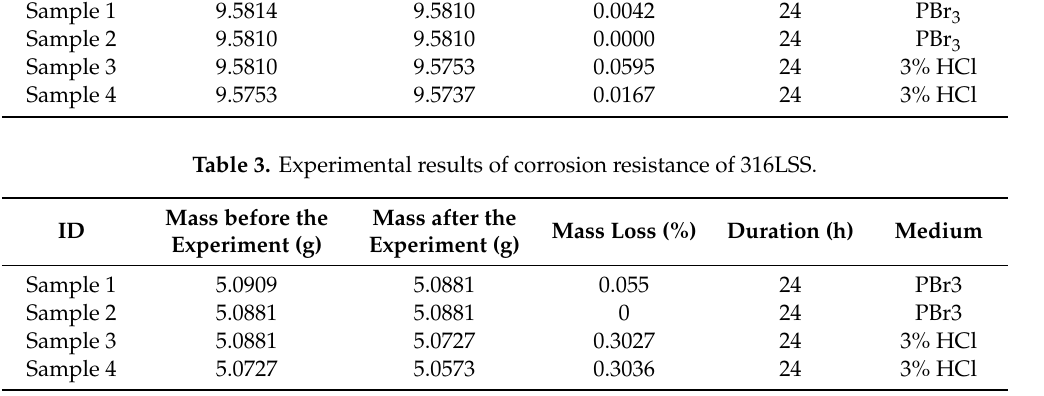
Table 2. Experimental results of corrosion resistance of IN718.